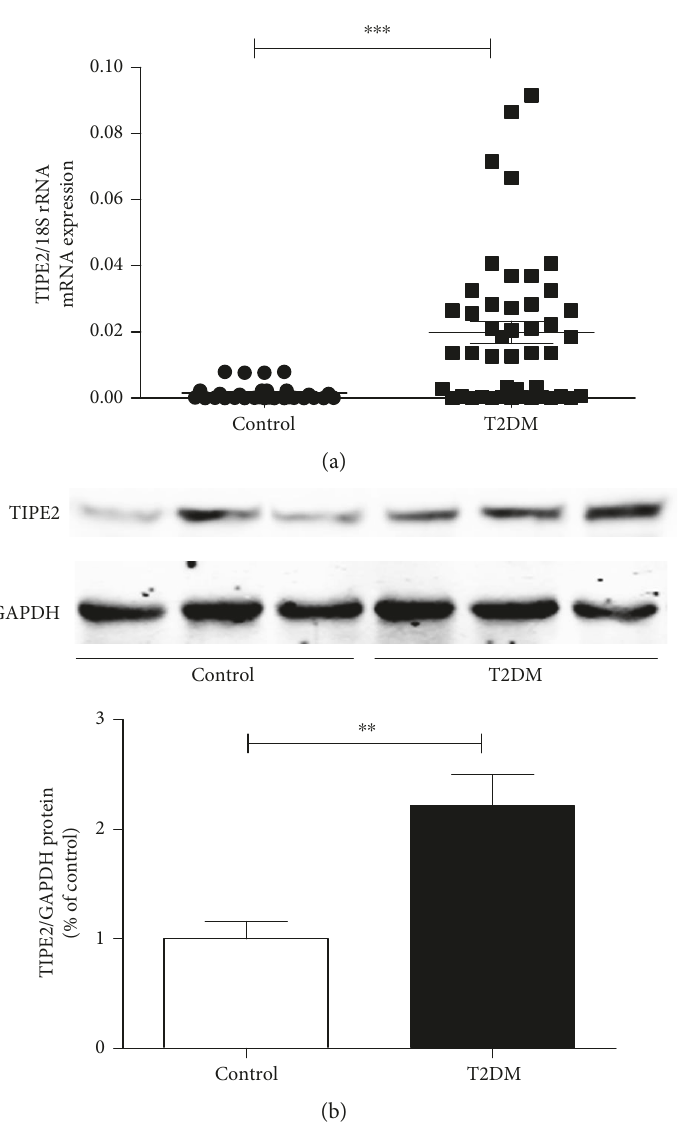
Figure 1: TIPE2 expression levels in PBMCs from individuals with T2DM and healthy participants. TIPE2 expression was determined by RT- PCR and Western blotting. The mRNA levels of TIPE2 were obviously higher in PBMCs from T2DM patients ( n = 46 ) compared with those from healthy controls ( n = 30 ) (a). Every point depicts a speci fi c participant, and the median value is indicated for each group. Statistical comparisons were performed using the Mann – Whitney U test. The TIPE2 protein levels were obviously upregulated in PBMCs from T2DM patients compared with those from healthy controls (b). Representative results of three individual experiments were shown for the TIPE2 expression in PBMCs. ∗∗∗ P < 0 001 versus control; ∗∗ P < 0 01 versus